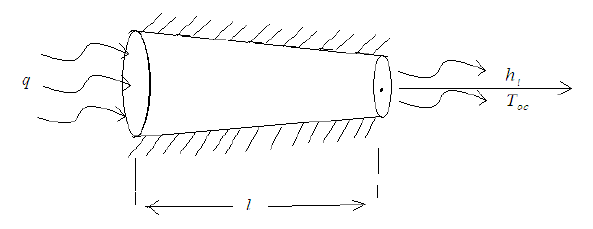
Figure 1: Calculation scheme of the